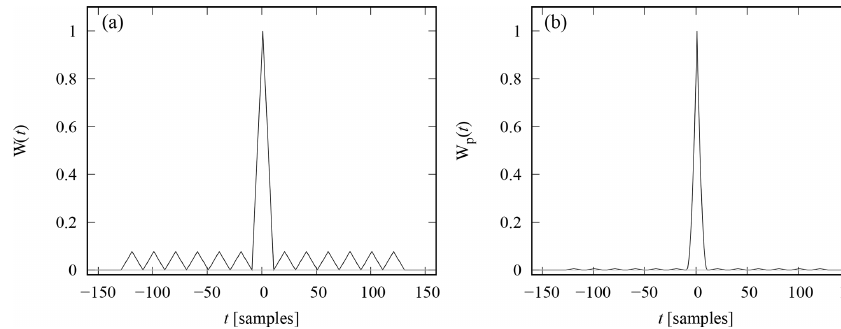
Figure 1. Point spread function (a) and zero-lag range ambiguity function (b) of a 13-bit Barker